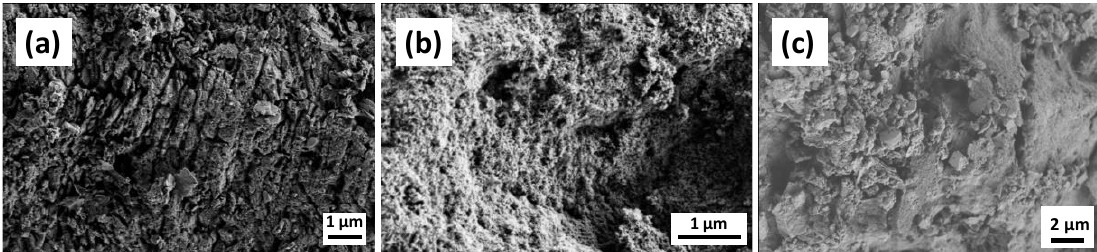
Figure 3. SEM images of ( a ) sand; ( b ) C-MNA adsorbent material; and ( c ) mixture of sand and C-MNA composite material.